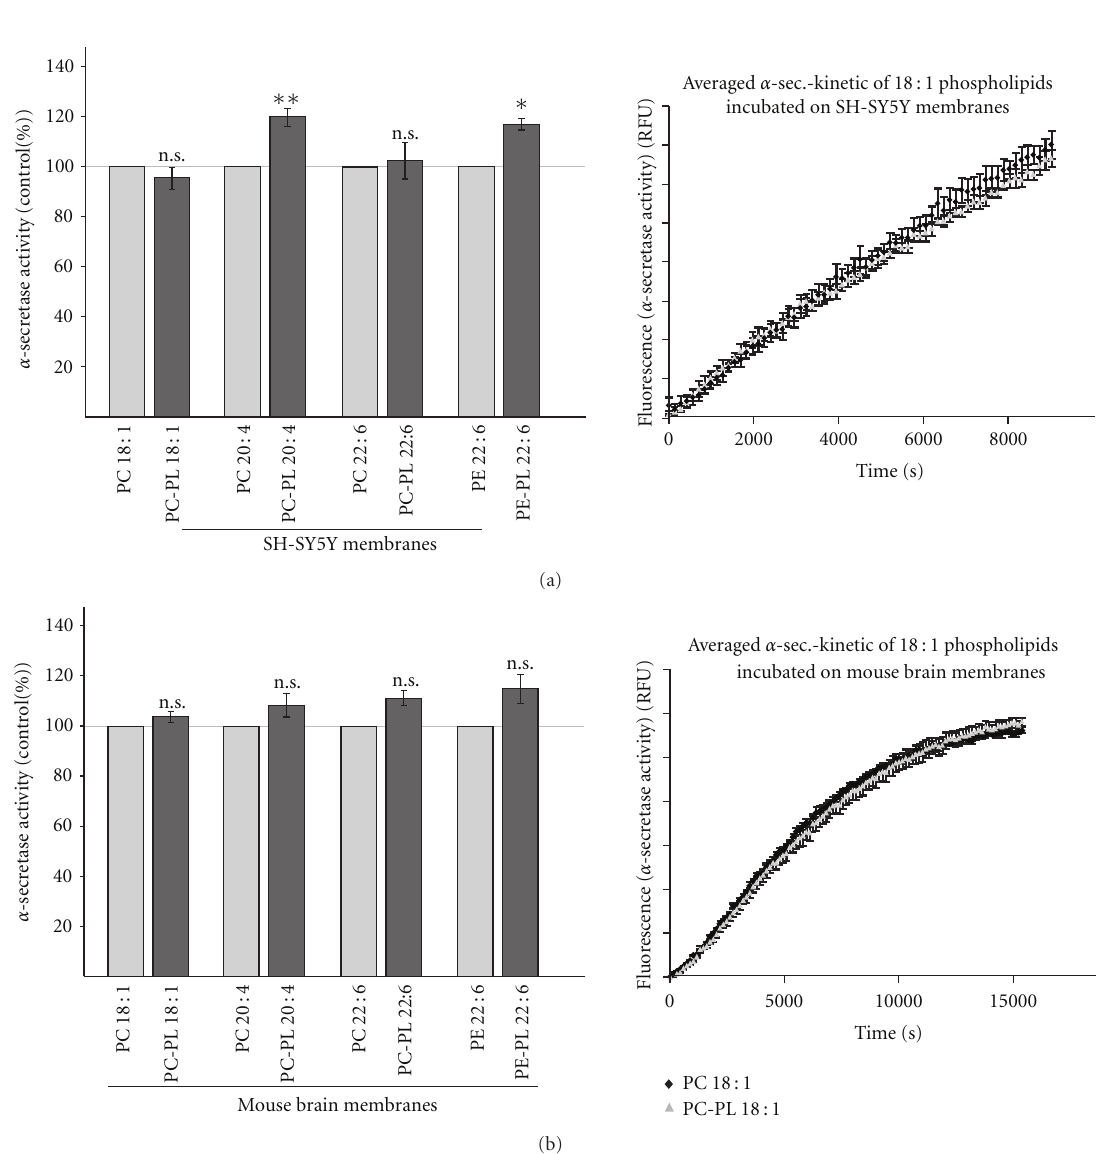
Figure 5: E ff ect of PC-PL 18:1, PC-PL 20 :4, PC-PL 22: 6, and PE-PL 22:6 on α -secretase activity. PC-PL 18: 1, PC-PL 20:4, PC-PL 22 :6 and PE-PL 22:6 and the corresponding phospholipids (100 μ M) were incubated on purified membranes of (a) human SH-SY5Y cells and (b) mouse brains, and α -secretase activity was determined as described in materials and methods. (a, b) Representative kinetics were shown for PC-PL 18:1 and PC 18:1. All quantified data represent an average of at least three independent experiments. Illustration and statistical significance as described for Figure